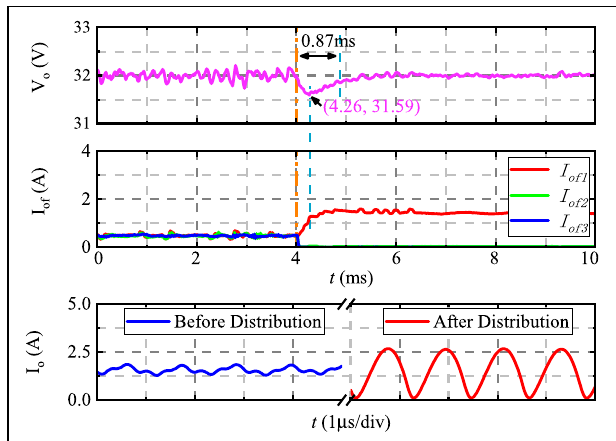
FIGURE 12 | Experimental waveforms of the load distribution scheme switching at